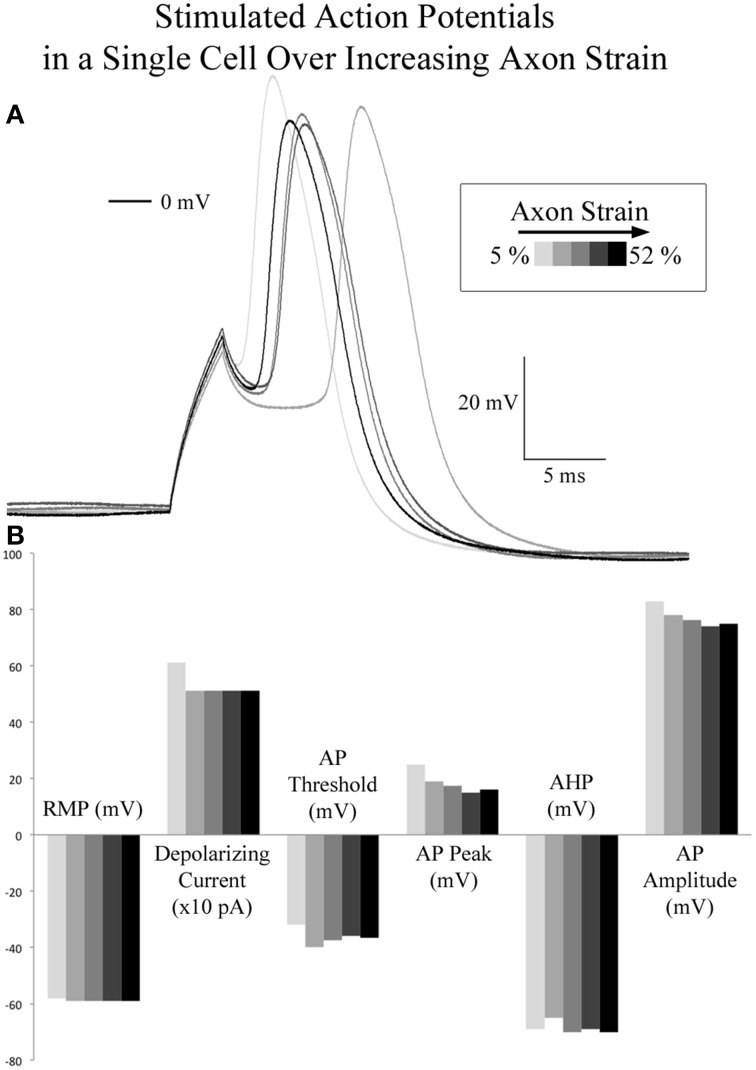
Current stimulated action potentials during real-time axon stretch. (A) Overlaid current stimulated action potential traces corresponding to 5, 10, 21, 37, and 52% axon strain in a single cell. (B) Action potential attributes did not correlate with axon strain. At 500 pA depolarizing current, peak voltage decreased by 3 mV as strain was increased 42%.